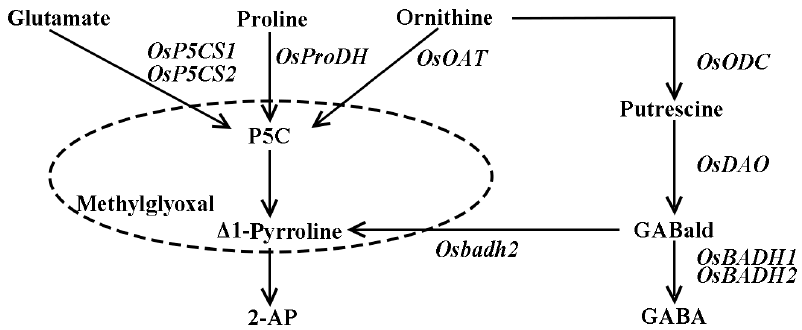
Figure 1. The schematic representation of 2AP biosynthesis pathway in fragrant rice.